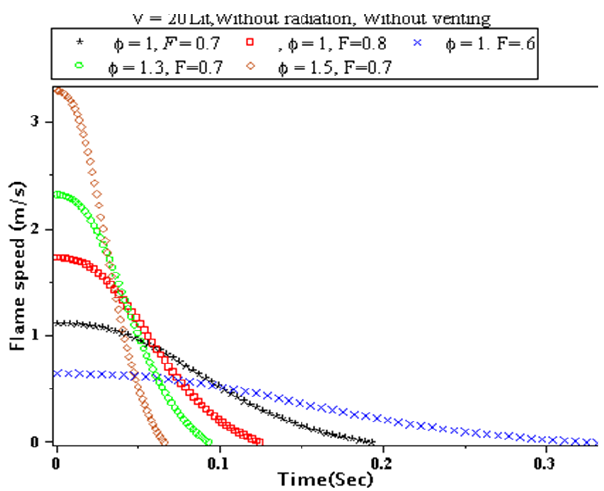
Fig. 9. Effect of fuel concentration and volatility on flame speed.